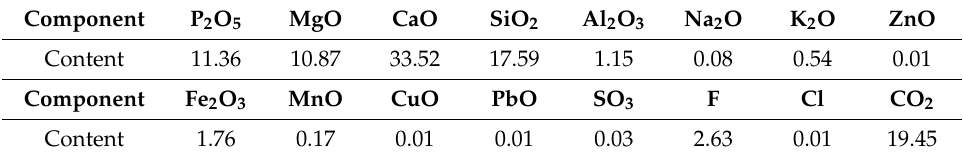
Table 1. Chemical composition of the feed by X-ray fluorescence (XRF) analysis (wt %). Component